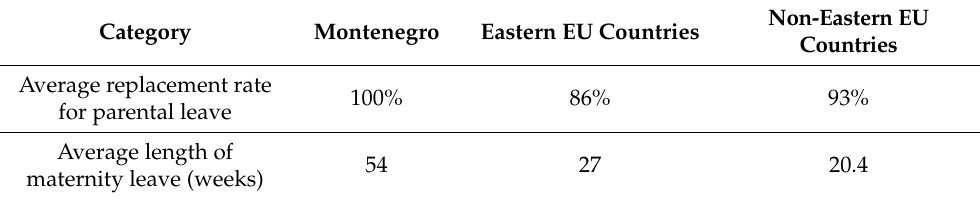
Table 3. Replacement rates for parental and average length of maternal leaves in